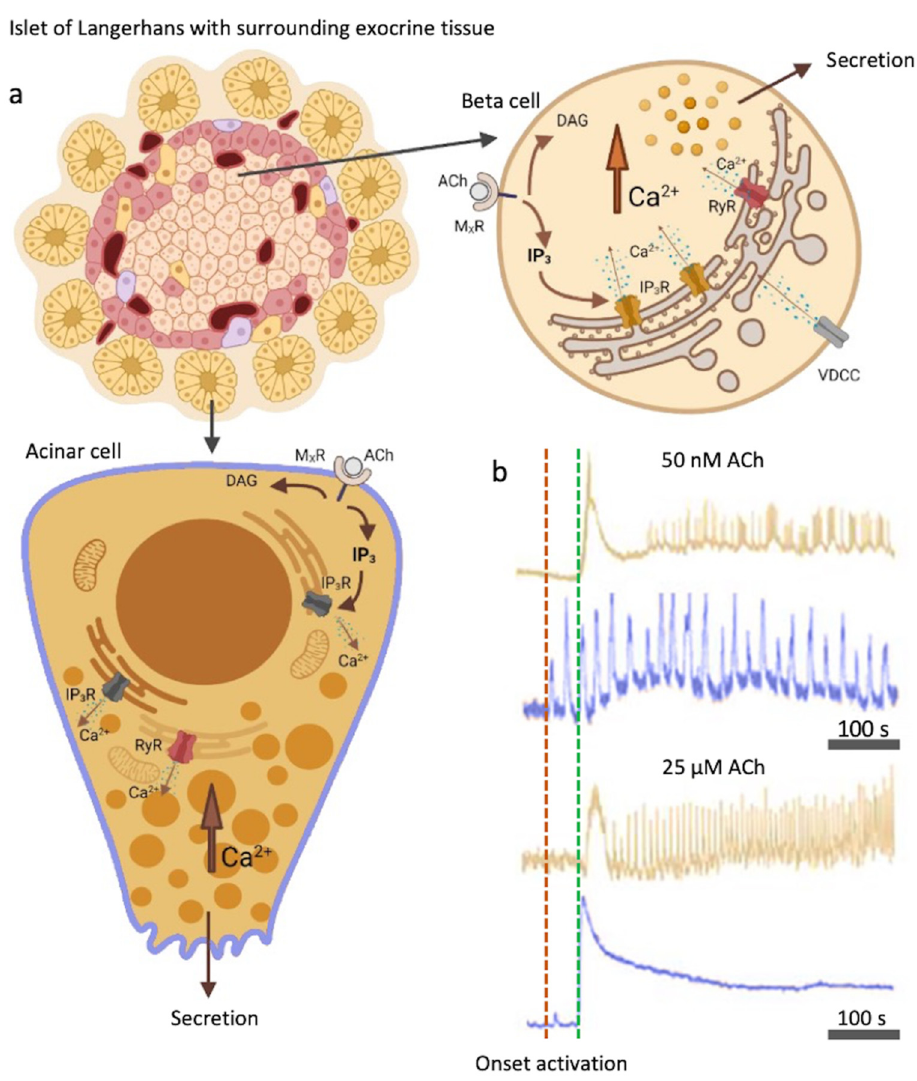
Figure 1. Muscarinic activation with ACh and the IP 3 signaling pathway in beta cells and acinar cells. ( a ) Acinar and beta cells express muscarinic receptors (M X Rs), activation of which results in IP 3 and DAG production. IP 3 specifically binds to IP 3 R on the ER and triggers Ca 2+ mobilization, leading to an oscillatory rise in [Ca 2+ ] c . Additionally, RYR receptors can be activated. L-type VDCCs play a role in Ca 2+ refilling of the ER. ( b ) Color-coded time courses for beta (light brown) and acinar cells (blue) simultaneously stimulated with 8 mM glucose in combination with a physiological (50 nM, top traces) or a supraphysiological (25 µM, bottom traces) ACh concentration. The activation onsets after the cells were stimulated for the acinar cells (red) and the beta cells (green) are indicated with the vertical dashed lines. Legend: M x R = muscarinic receptor, ACh = acetylcholine, DAG = diacylglycerol, IP 3 = 1,4,5-inositol trisphosphate, IP 3 R = inositol (1,4,5) trisphosphate receptor, RYR = ryanodine receptors. Created with [40].